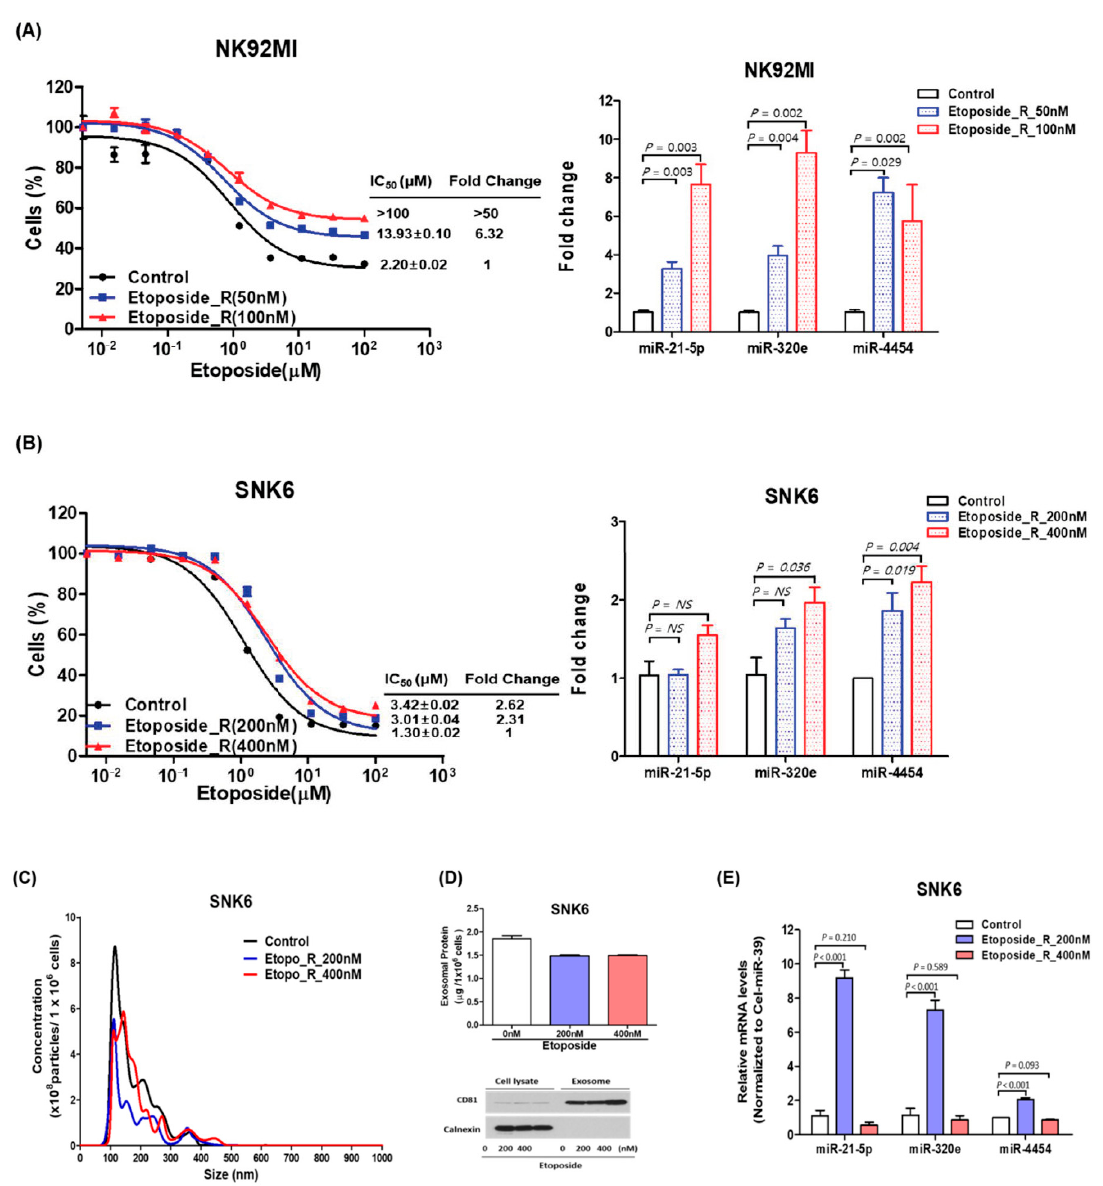
Figure 4. Expression of miR-21-5p, miR-320e, and miR-4454 in etoposide-resistant NKTL cell lines. ( A ) NK92MI (NK92MI_Etopo_R) cells showed significant resistance to etoposide compared with control cells. Cells were incubated with di ff erent concentrations of etoposide for 72 h and subjected to the CCK-8 assay. The expression levels of miR-21, miR-320e, and miR-4454 were increased in etoposide-resistant cells. ( B ) SNK6 (SNK6_Etopo_R) cells showed significant resistance to etoposide and increased expression levels of miR-21, miR-320e, and miR-4454 compared with control cells. ( C ) Nanoparticle tracking analysis showed no di ff erence among control SNK6 cells and etoposide-resistant SNK6 cells. ( D ) Exosome amount and marker expression were not di ff erent between etoposide-resistant cell lines and control cells. ( E ) The expression levels of miR-21, miR-320e, and miR-4454 in exosomes isolated from SNK6 cells resistant to etoposide 200 nM were higher than in those of control